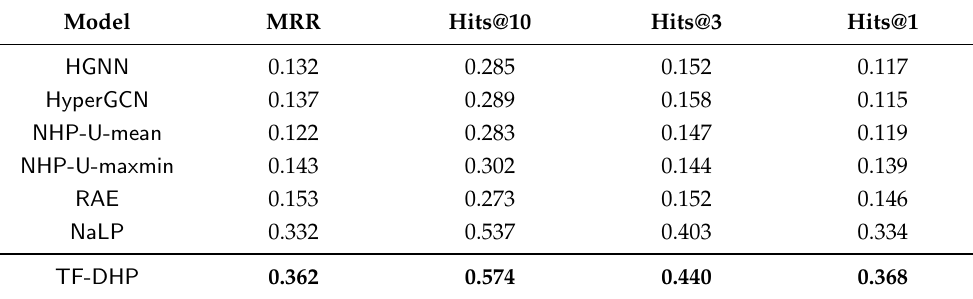
Table 4. Undirected hyperlink prediction results on WikiPeople dataset.